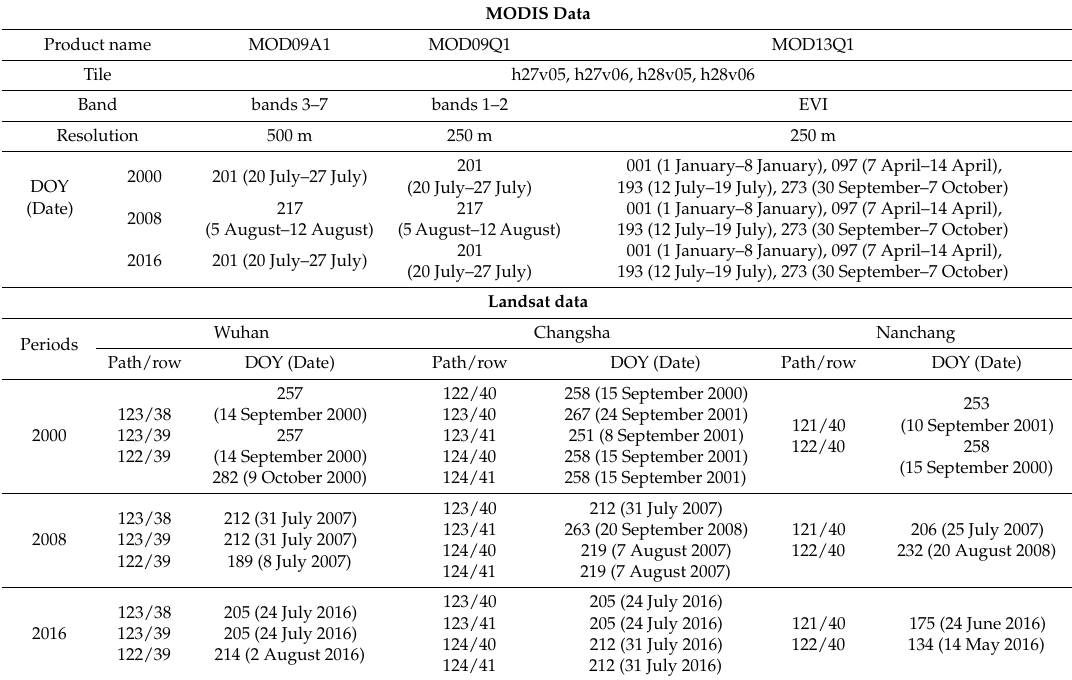
Table 1. RS data used in this